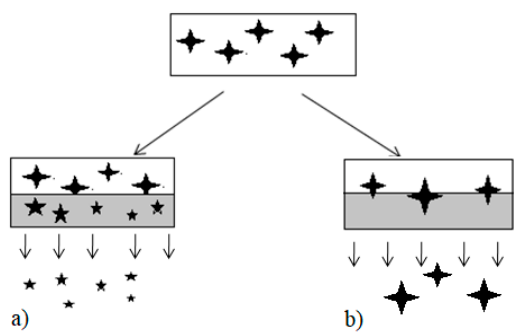
Figure 1. Schematic diagram shows ( a ) Carrier-controlled dissolution and ( b ) drug-controlled dissolution (Adapted with permission from [11], copyright Elsevier, 2002). The larger represents dissolved drug, the smaller represent the partially dissolved drug. Grey box represents an aqueous environment.